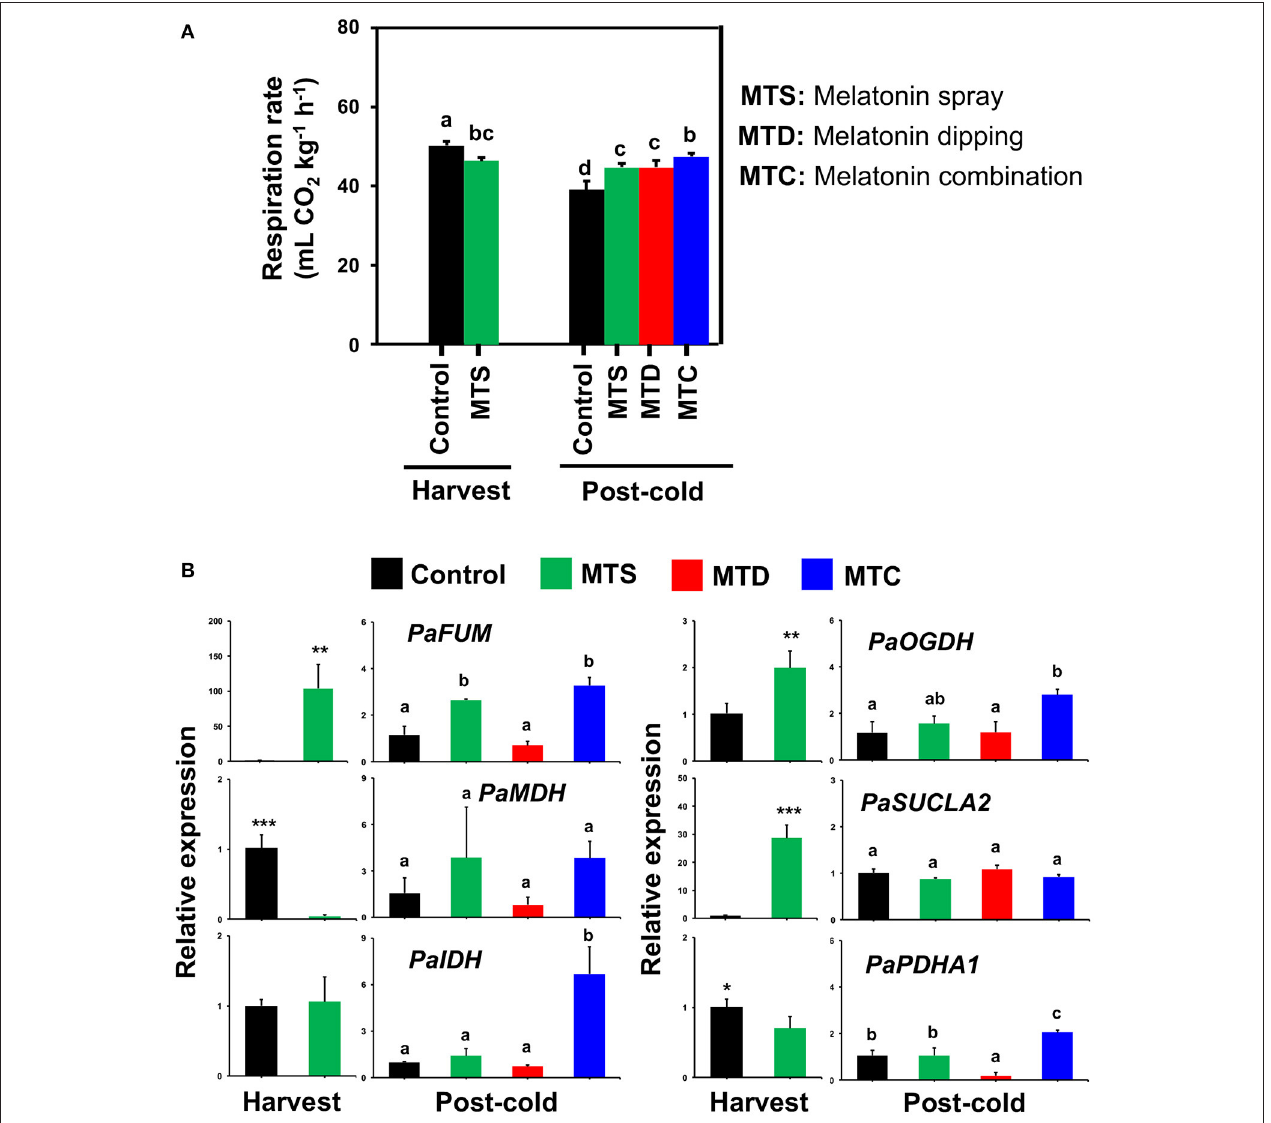
FIGURE 2 | (A) Respiration activity of sweet cherries at harvest and post-cold period in response to various pre- and post-harvest melatonin application (MTD, melatonin dipping; MTS, melatonin spray; MTC, melatonin combination). Experiment was performed as described in Figure 1 and under Materials and